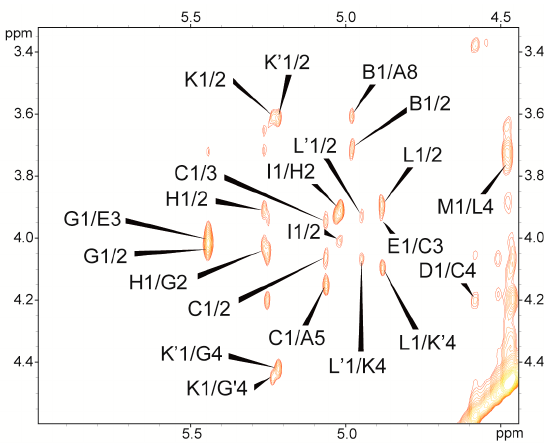
Figure 4. Selected part of the NOESY spectrum of the core oligosaccharide of P. penneri 40A LPS. The cross-peaks are labeled as shown in the text.